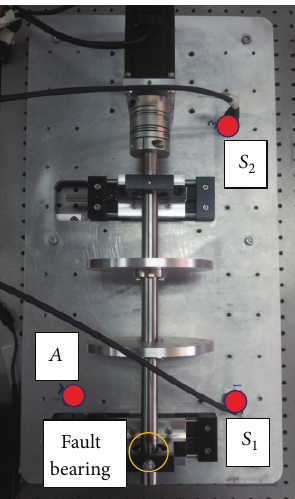
Figure 4: Experimental setup and measurement points ( 𝑆 1 and 𝑆 2 are the main measurement points, and 𝐴 is an auxiliary measure- ment